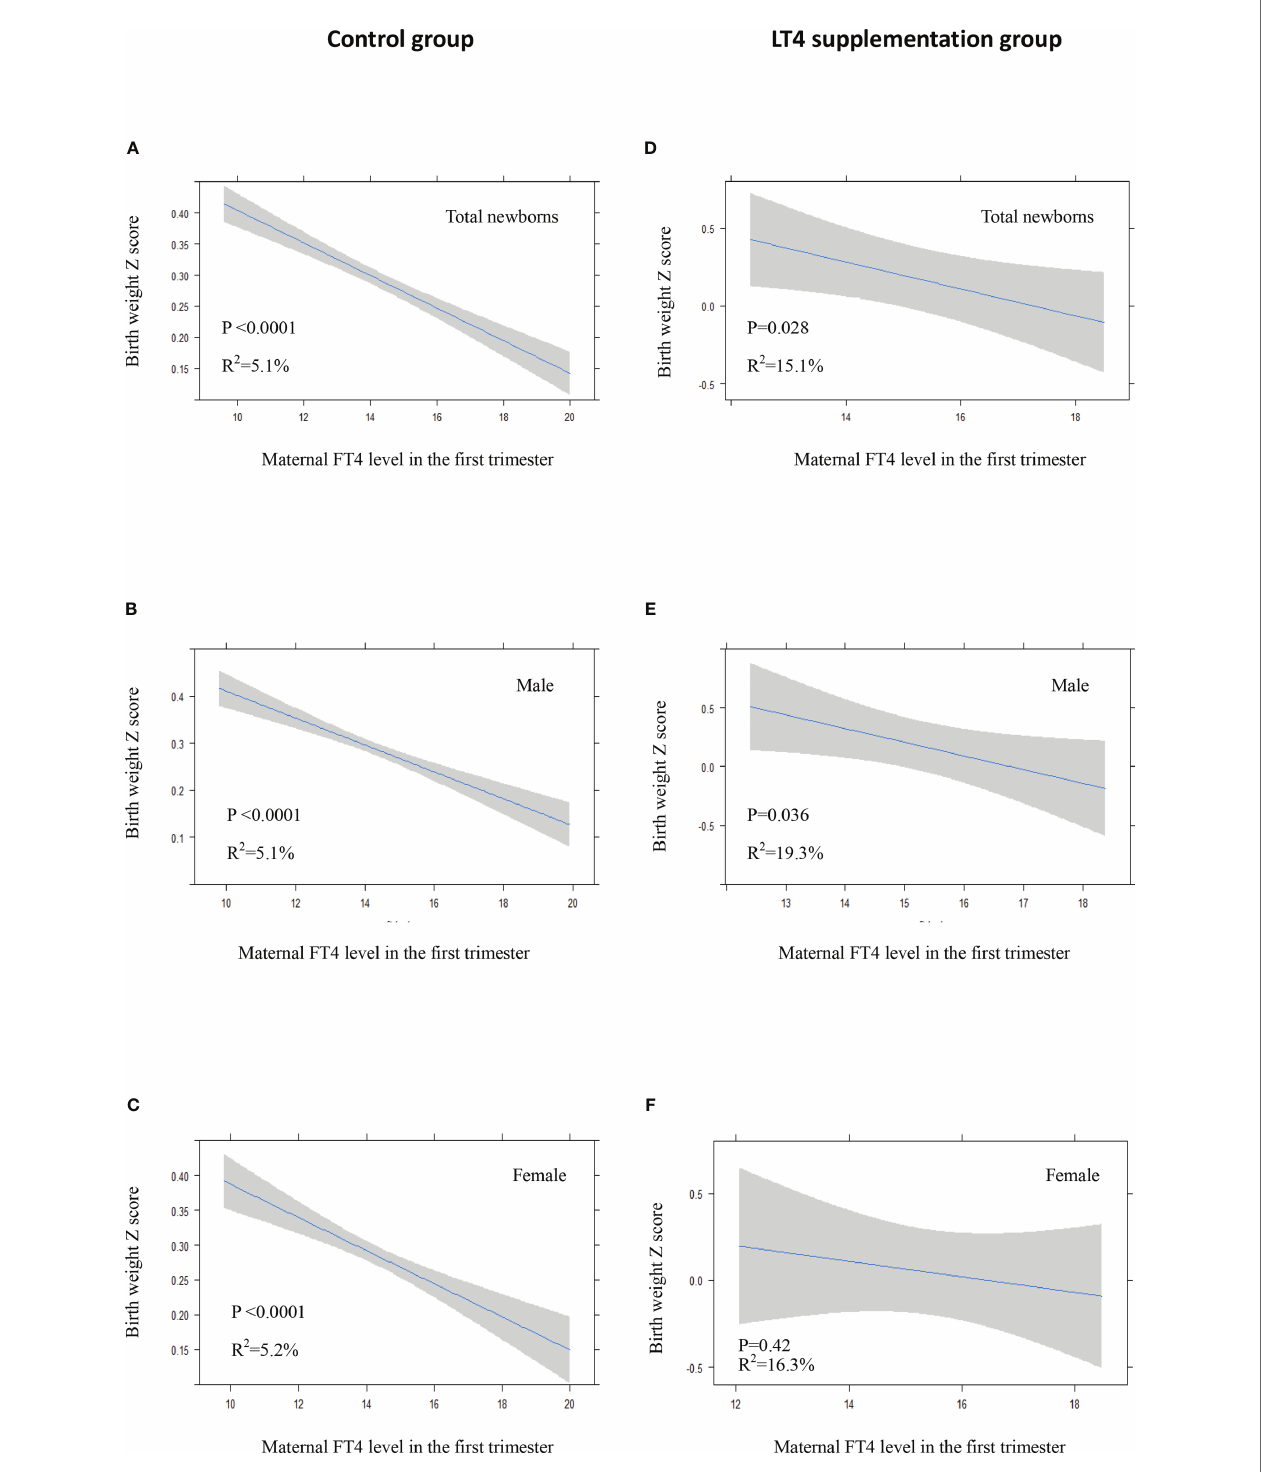
FIGURE 4 | In adjusted model: Plots show the association of maternal FT4 level in the fi rst trimester with birth weight of total newborns (A, D) , male newborns (B, E) and female newborns (C, F) in control group (A – C) and LT4 supplementation group (D – F) as predicted mean (blue line) with 95% con fi dence interval (CI, gray area). The neonatal birth weight was standardized for Z score. Analyses were adjusted for gestation age at birth, maternal age, body mass index (BMI), pregnancy- induced hypertension (PIH), gestational diabetes mellitus (GDM), and fetal